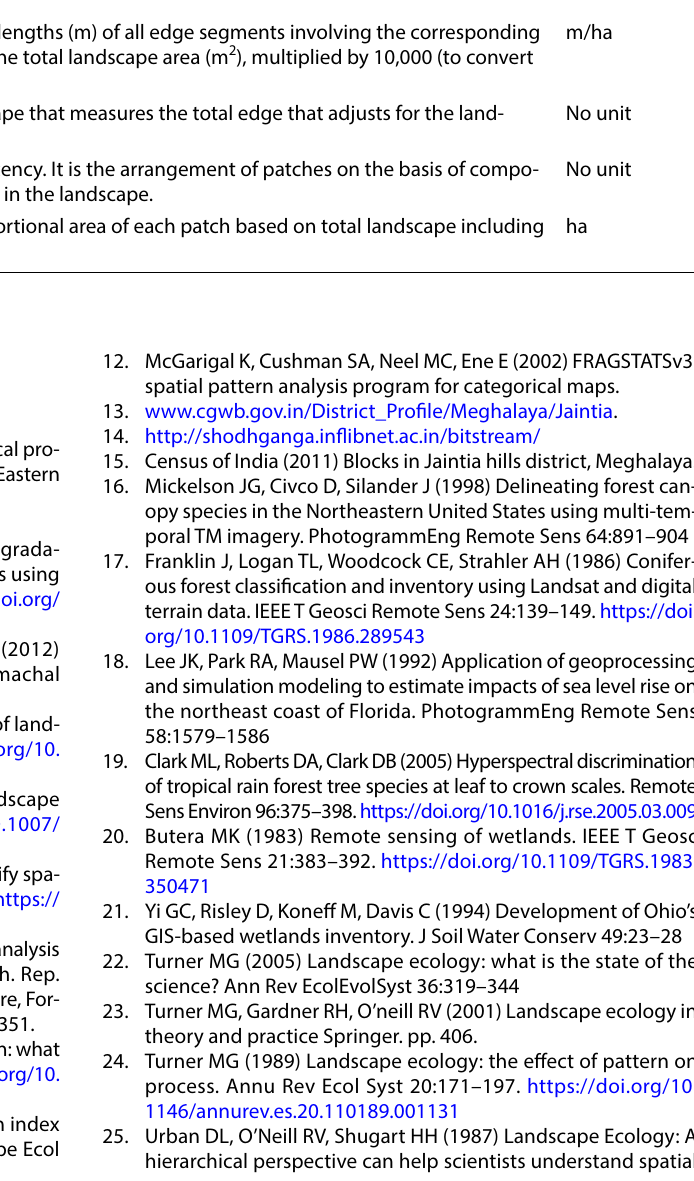
Edge density m/ha